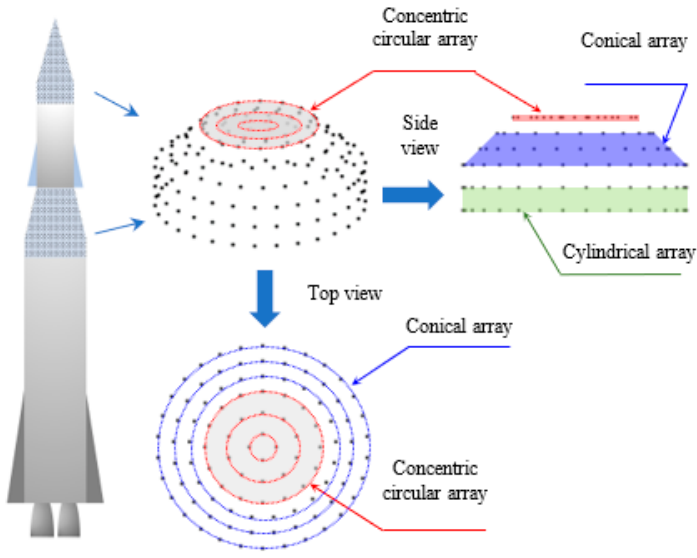
Figure 5. Concentric circular (CSC 4 ) antenna array structure.